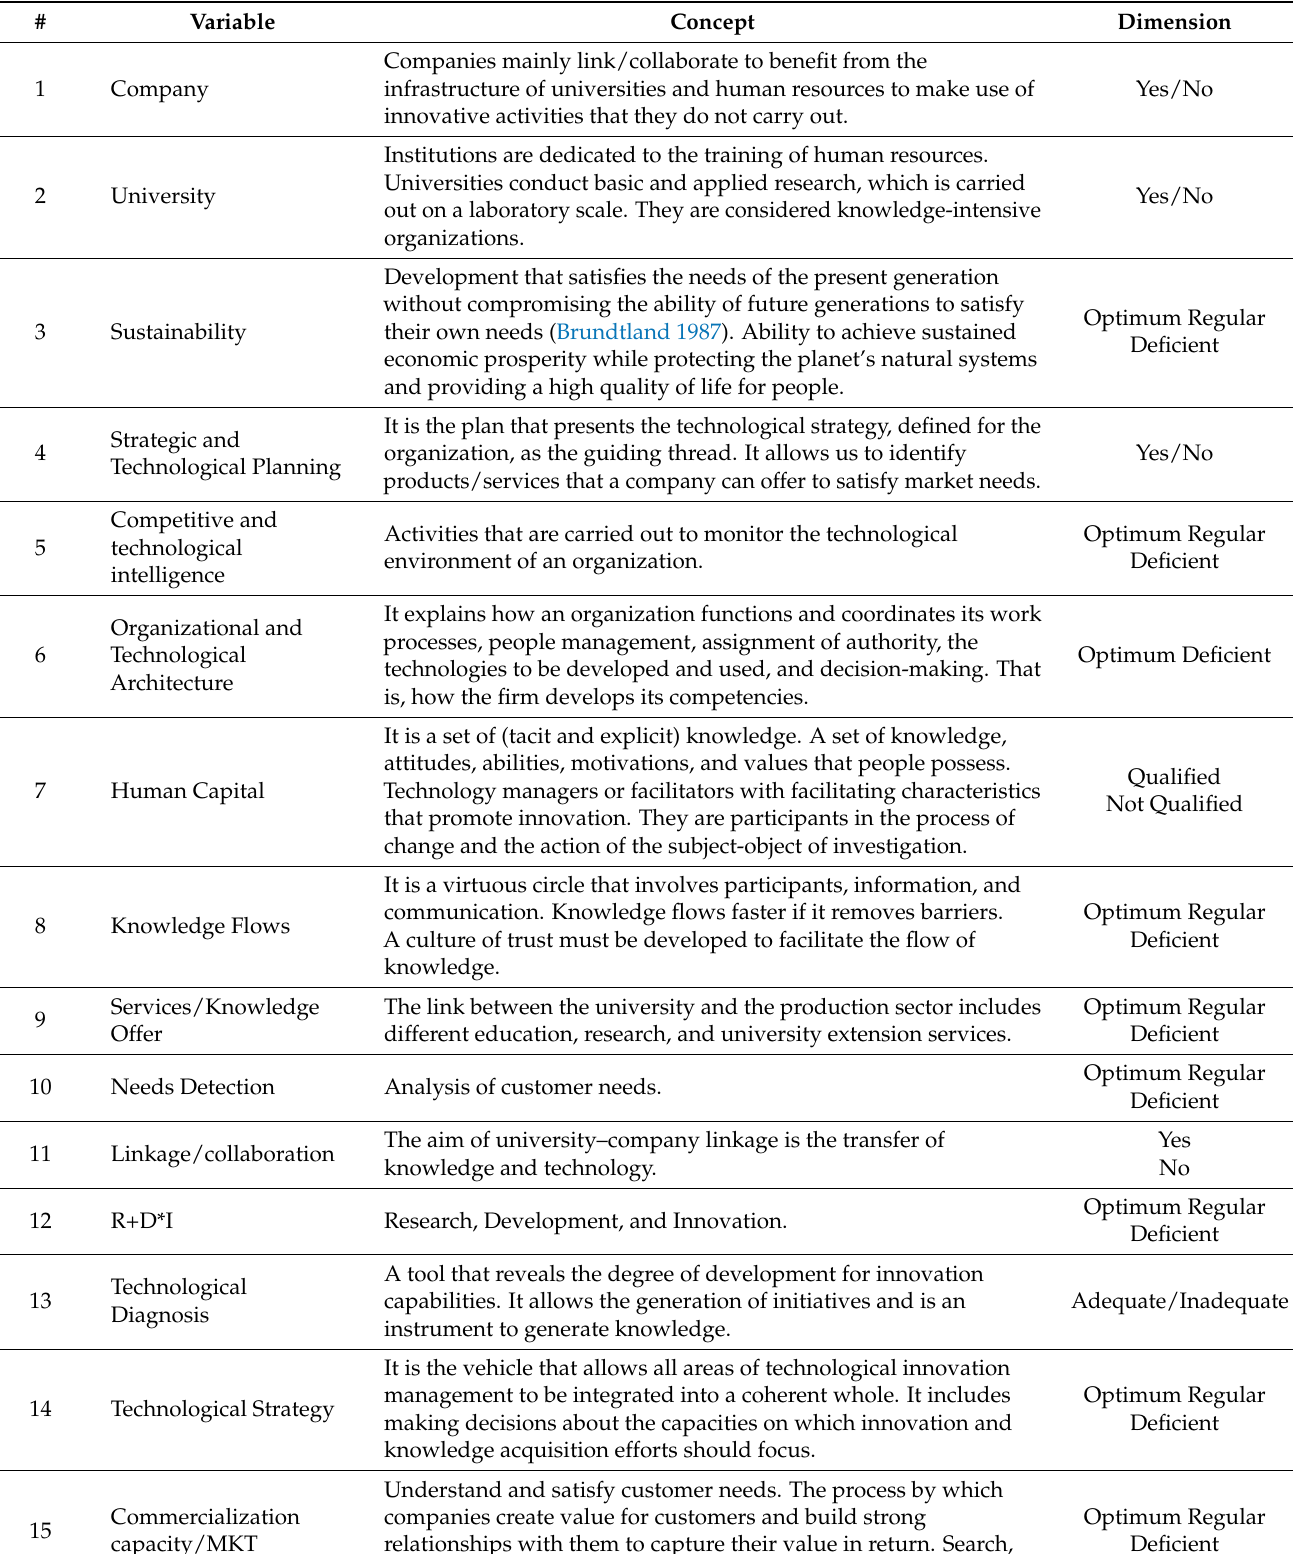
Table 1. Definition of the variables and